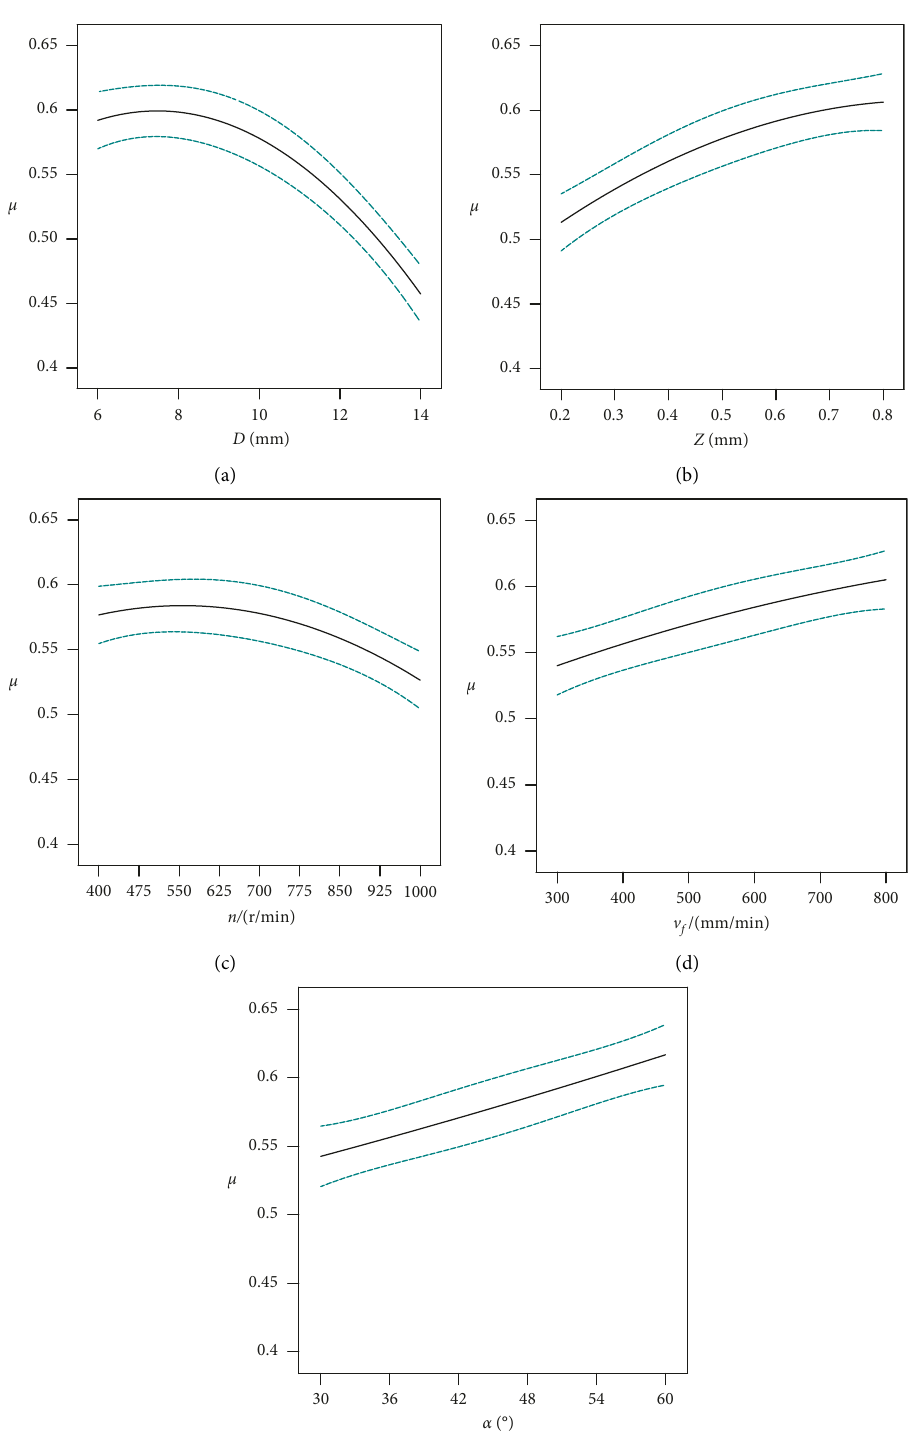
Figure 15: Main effects plot: (a) μ � f ( D ). (b) μ � f ( Z ). (c) μ � f ( n ). (d) μ � f (vf). (e) μ � f ( α